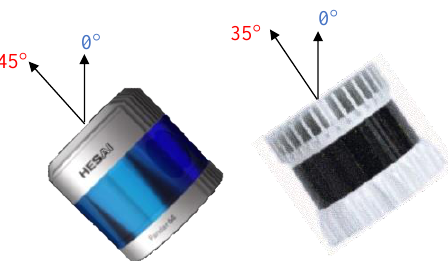
Figure 26. Ideal angular orientation of the selected Lidar devices. ( left ) Pandar64. ( right ) Ouster OS- 1-64.